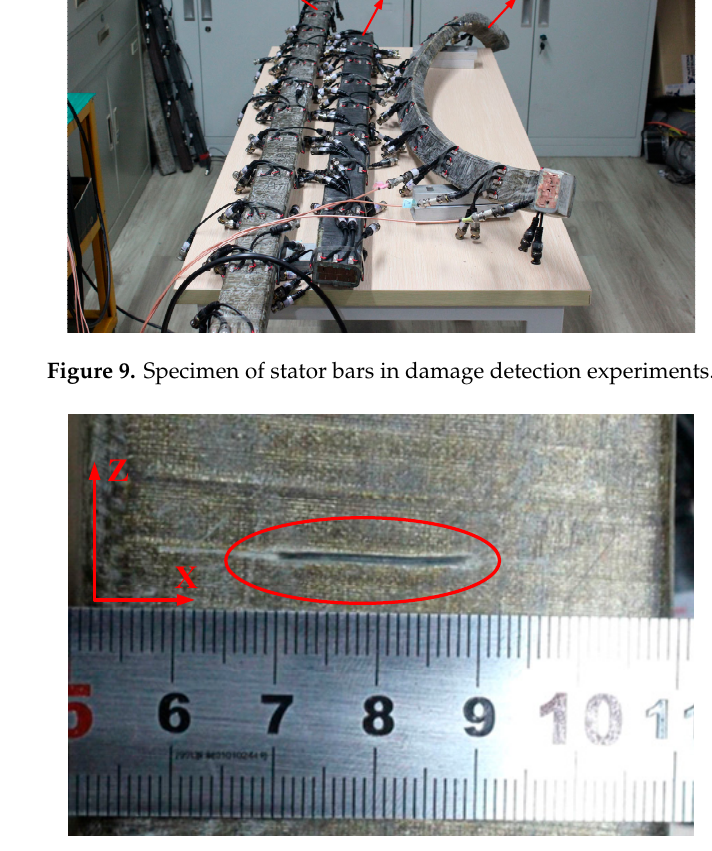
Figure 10. The surface crack damage. Sensors 2019 , 19 , x FOR PEER REVIEW